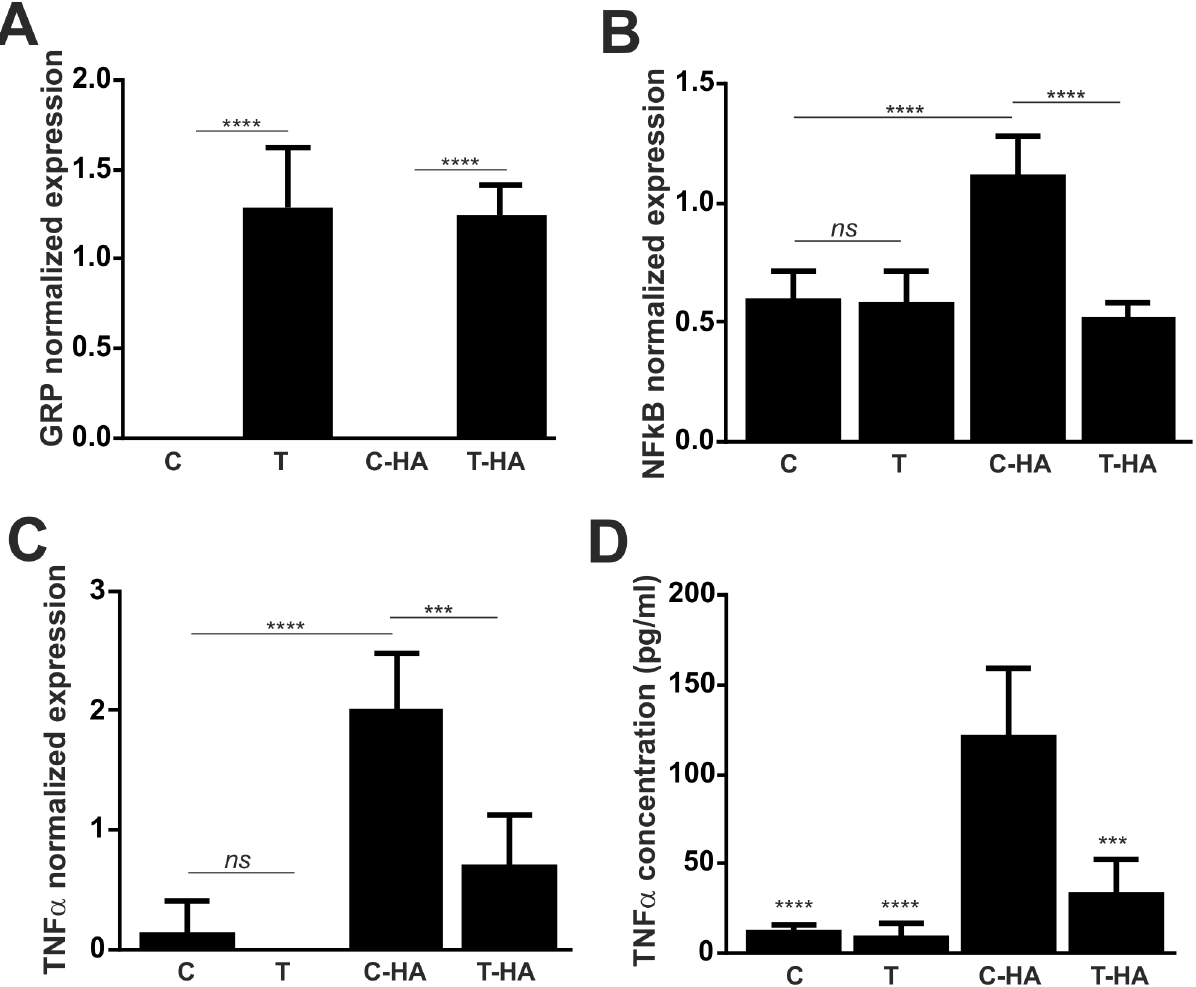
Fig 8. Overexpression of GRP in THP-1 cells rescueshydroxyapatite induced inflammation. THP-1 cells were transiently transfected with GRP mRNA for 24 h and either maintained in control conditions (C, T) or stimulatedwith HA (C-HA, T-HA) for additional 48 h. Gene expressionof GRP (A) and the inflammatory marker genesNFkB (B) and TNF α (C) were determined by qPCR (A), and levels of TNF α accumulationwere measuredby ELISA in conditionedculture media (D). (A-C) Data are presented as means (n = 6) ± standard error of triplicates of two independent experiments. Ordinary one-wayANOVA was used and multiple comparisons were achievedwith Tukey’s test. Statistical significancewas definedas P < = 0.01 ( ** ), P < = 0.001 ( *** )and P < 0.0001( **** ). ns , non-significant. (D) Data are presented as means (n = 4) ± standarderror of triplicates of two independent experiments. Ordinary one-wayANOVA was used and multiple comparisons were achievedwith Dunnett’s test. Statistical significancewas definedas P < = 0.001 ( *** )and P < 0.0001( ****